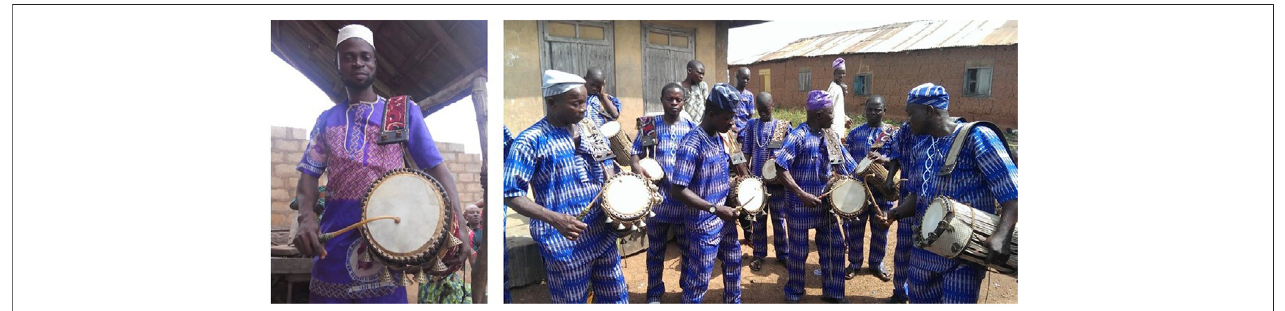
FIGURE 1 | Dùndún percussionists. Drummers can play individually, but more commonly in